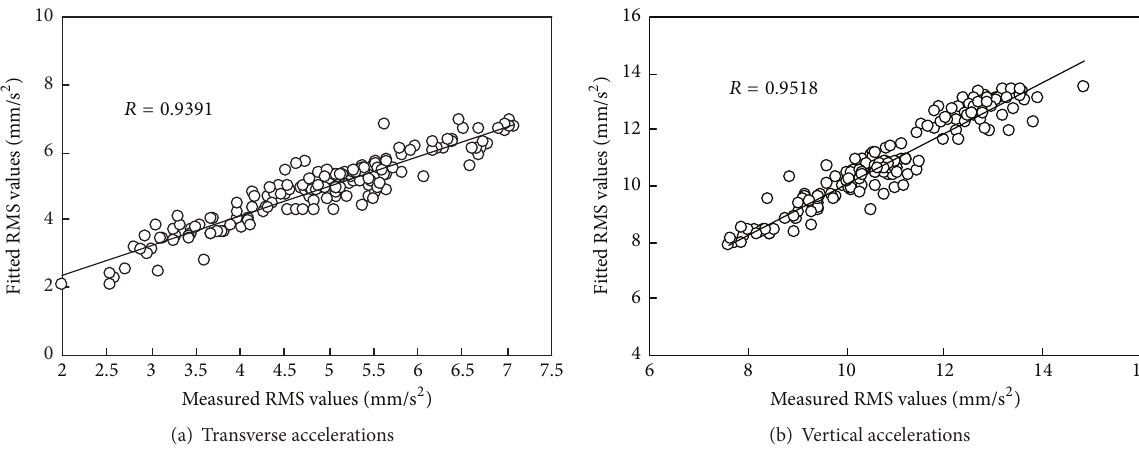
Figure 9: Fitting effect of cross-correlation between RMS values of accelerations by using quadratic